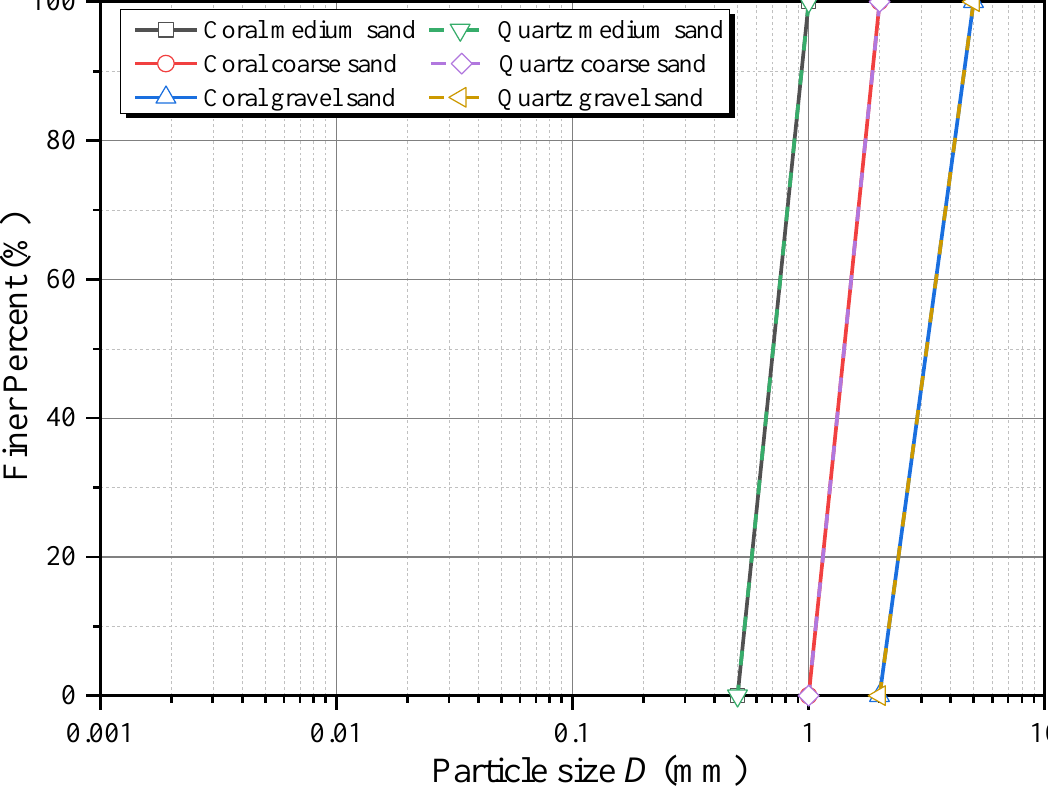
Figure 2. Particle size distribution curves of the tested materials.